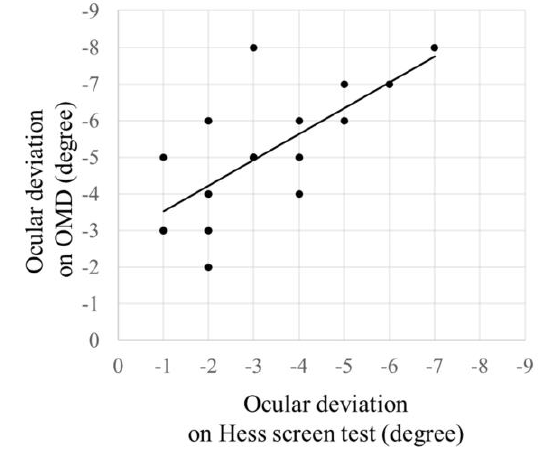
Figure 2: Comparison of the nine gaze-directions obtained using the Hess screen test and with the OMD